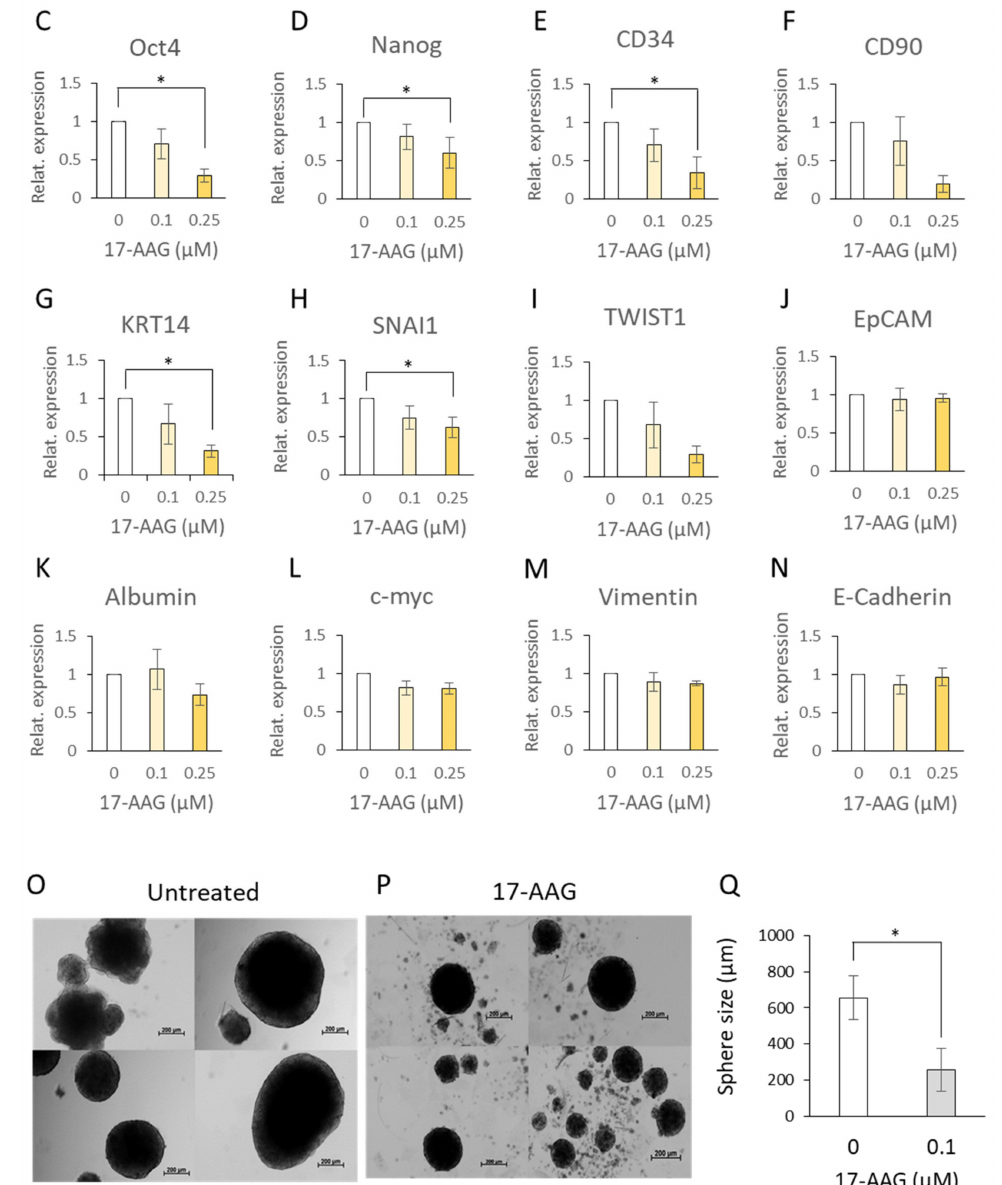
Figure 5. Treatment with 17-AAG-inhibited CD34+CD90+OV-6+csVimentin+ cells, where the HuH6 cells were treated with 0, 0.1 and 0.25 µ M 17-AAG. ( A ) After 48 h, the cell viability was measured in an MTT assay. The presented values are the means with error bars depicting the standard deviation from the mean. Dunn’s multiple comparisons test was performed in order to calculate the significance of the data. ( B ) The cells were measured for CD34 expression and OV-6 binding using flow cytometry. The values represent the means with error bars depicting the standard deviation from the mean. The assay was performed 4 times. Dunn’s multiple comparisons test was performed in order to calculate the significance of the data (* p < 0.05). ( C – N ) Gene expressions of Oct4, Nanog, CD34, CD90, KRT14, SNAI1, TWIST1, EpCAM, albumin, c-myc, vi- mentin and E-cadherin were measured in qPCR experiments. The fold-change values of the untreated cells were normalized to 1 and the values of the treated cells were calculated in relation to the respective values. The columns represent the means with error bars depicting the standard deviation from the mean ( n = 4). Dunn’s multiple comparisons test was performed in order to calculate the significance of the data (* p < 0.05). ( O , P ) Tumorsphere assays were performed with HuH6 cells, which were left untreated or treated with 0.1 µ M 17-AAG. ( Q ) The average sphere size was calculated from 3 independent experiments. A two-tailed Wilcoxon signed-rank test was performed in order to calculate the significance of the data (* p <